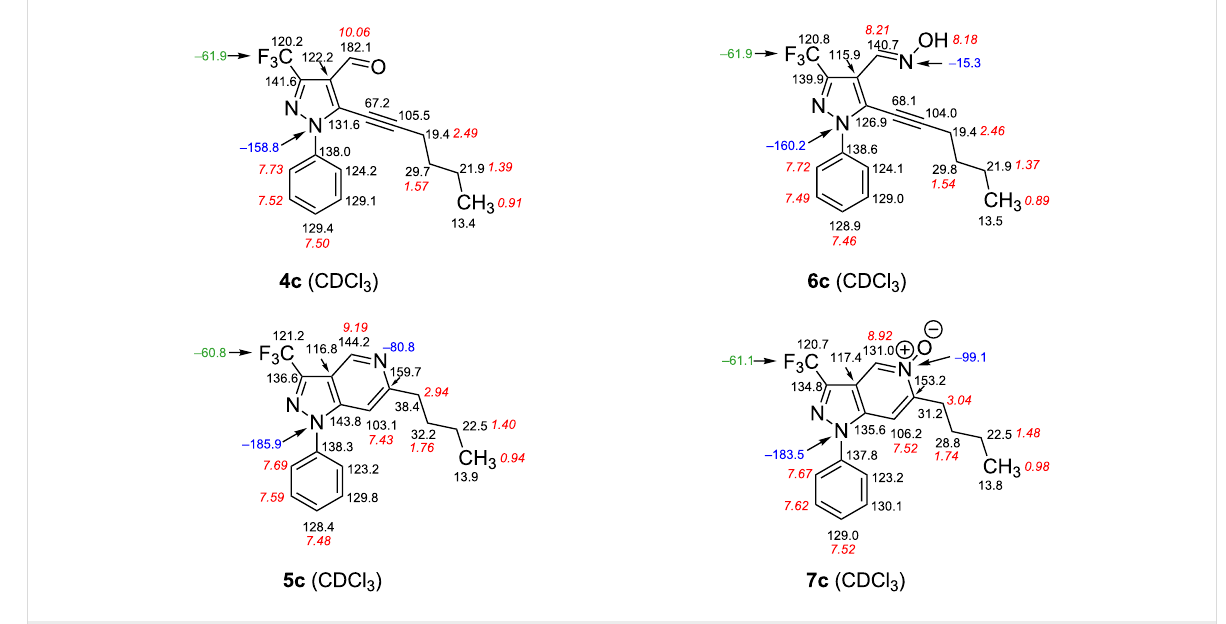
Figure 2: 1 H (in italics, red), 13 C (black), 15 N (in blue) and 19 F NMR (green) chemical shifts of compounds 4c , 5c , 6c and 7c (in CDCl 3